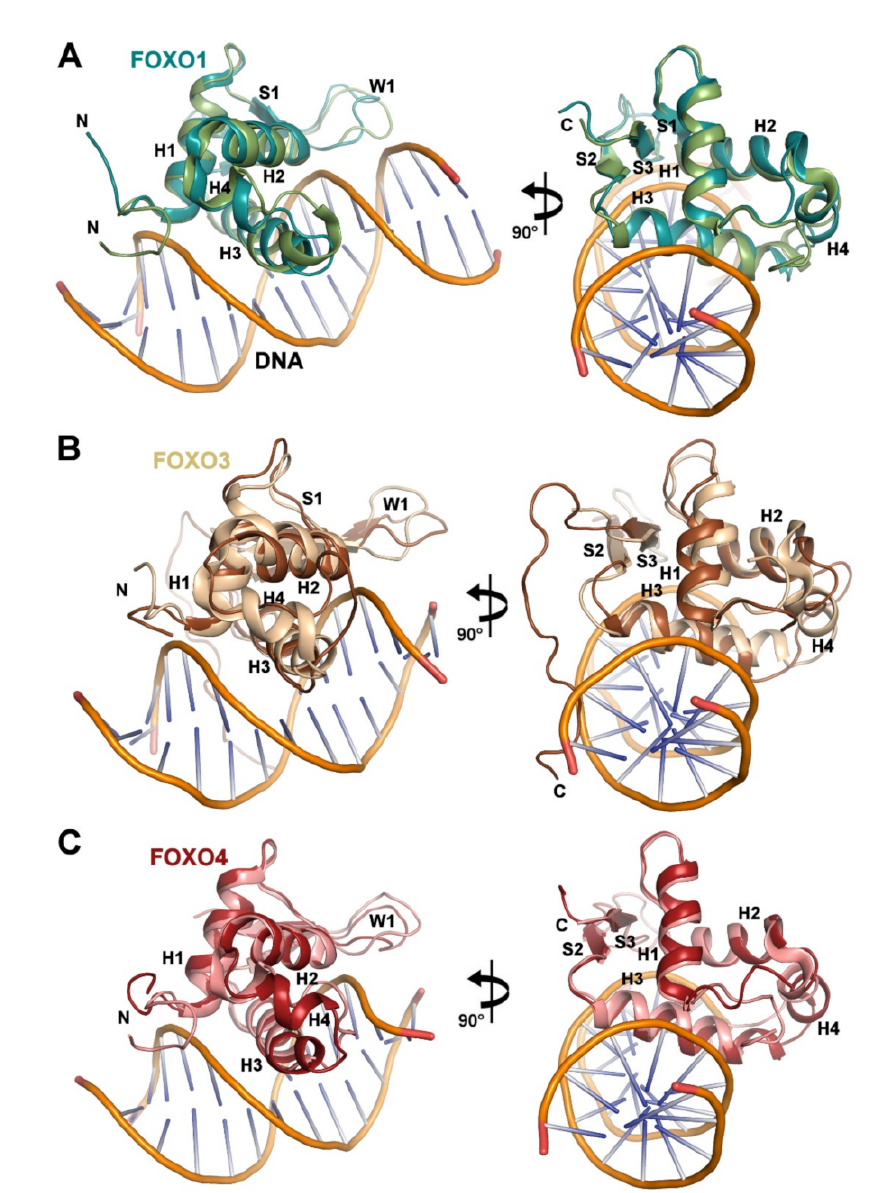
Figure 6. Comparison between apo and DNA-bound forms of FOXO-DBDs. ( A ) Superimposition